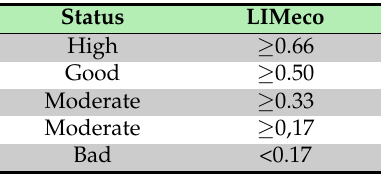
Table A5. Water-quality classification according to the LIMeco